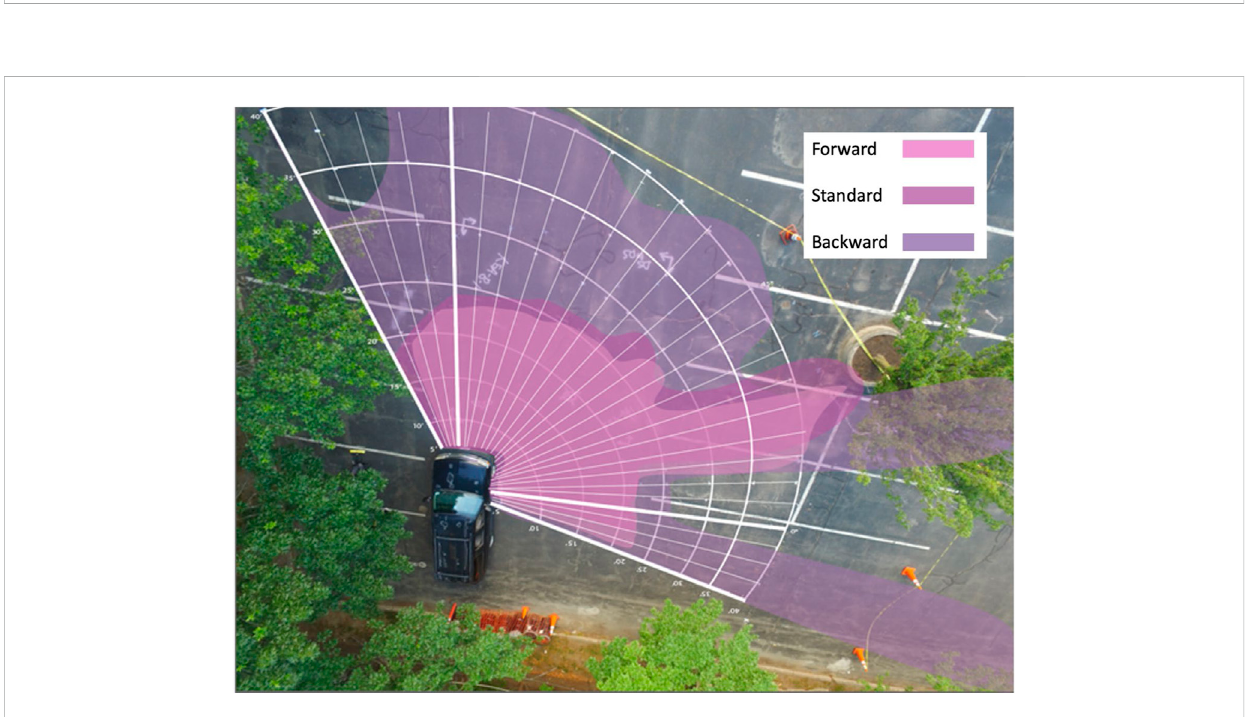
FIGURE 7 Nearest visible points for the one participant at the three different seating